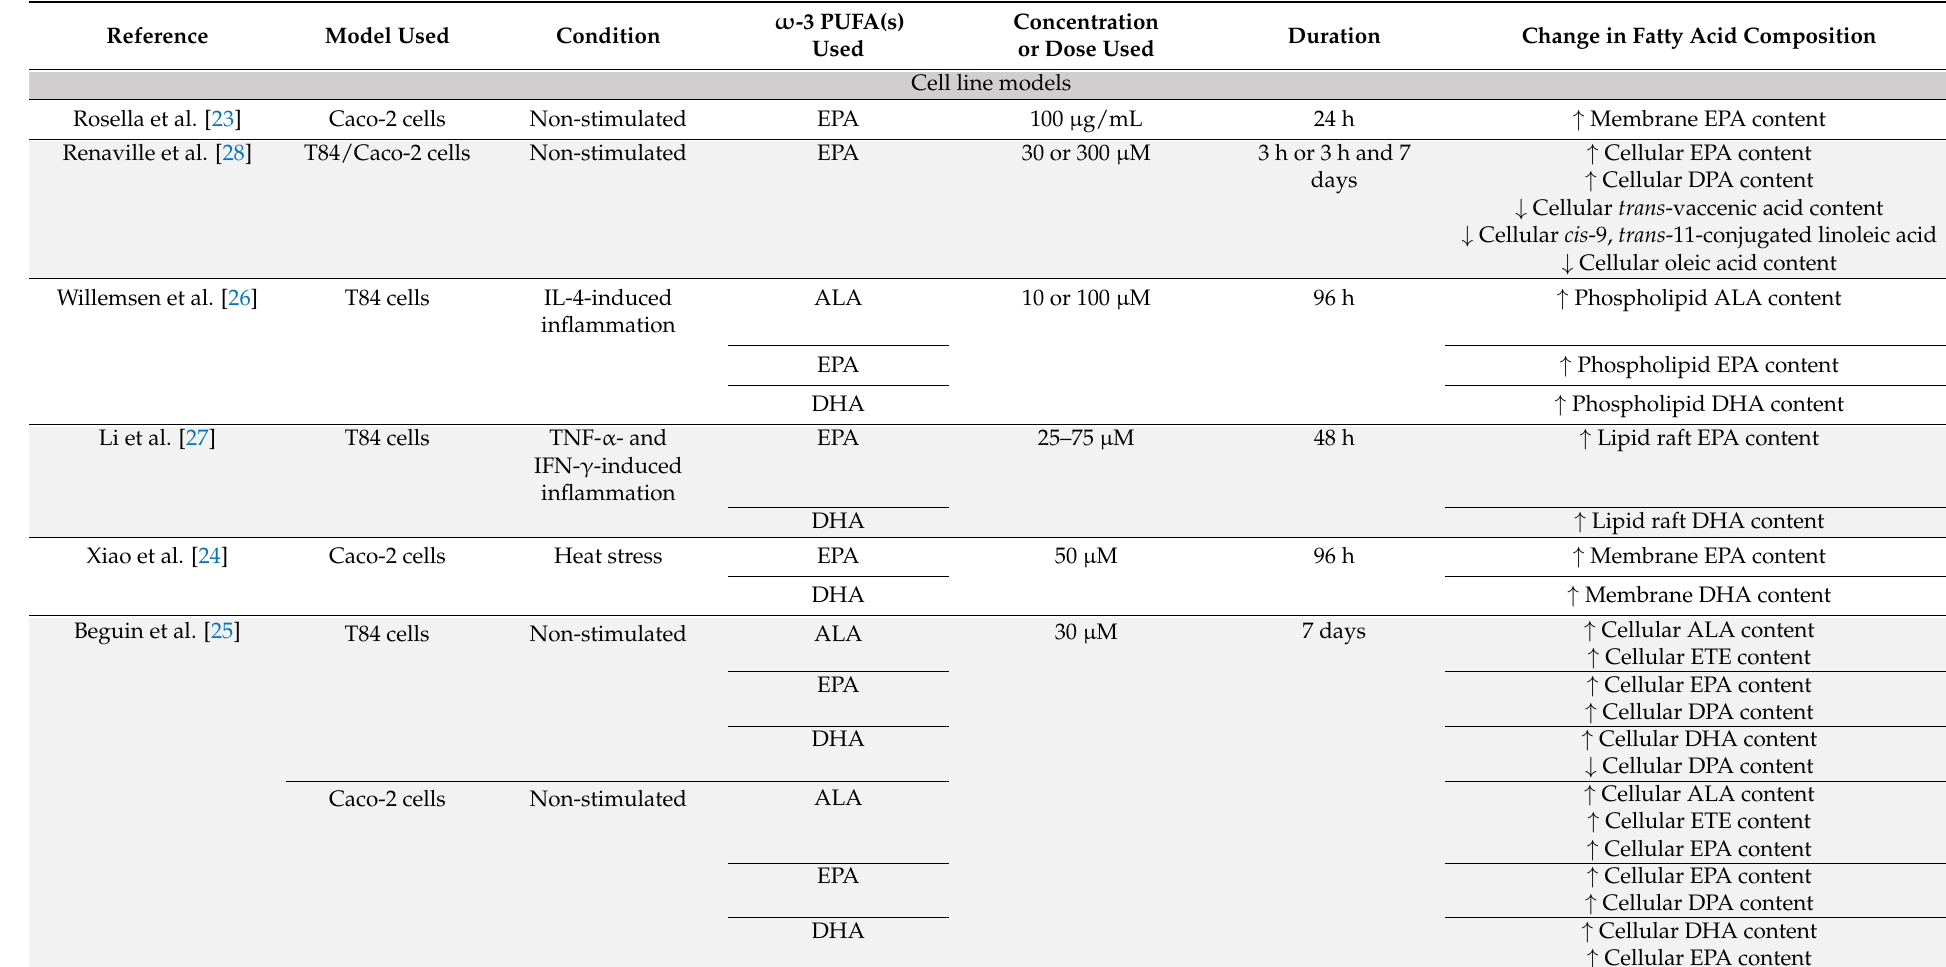
Table 1. Effects of ω -3 PUFAs on fatty acid composition in intestinal cell models or